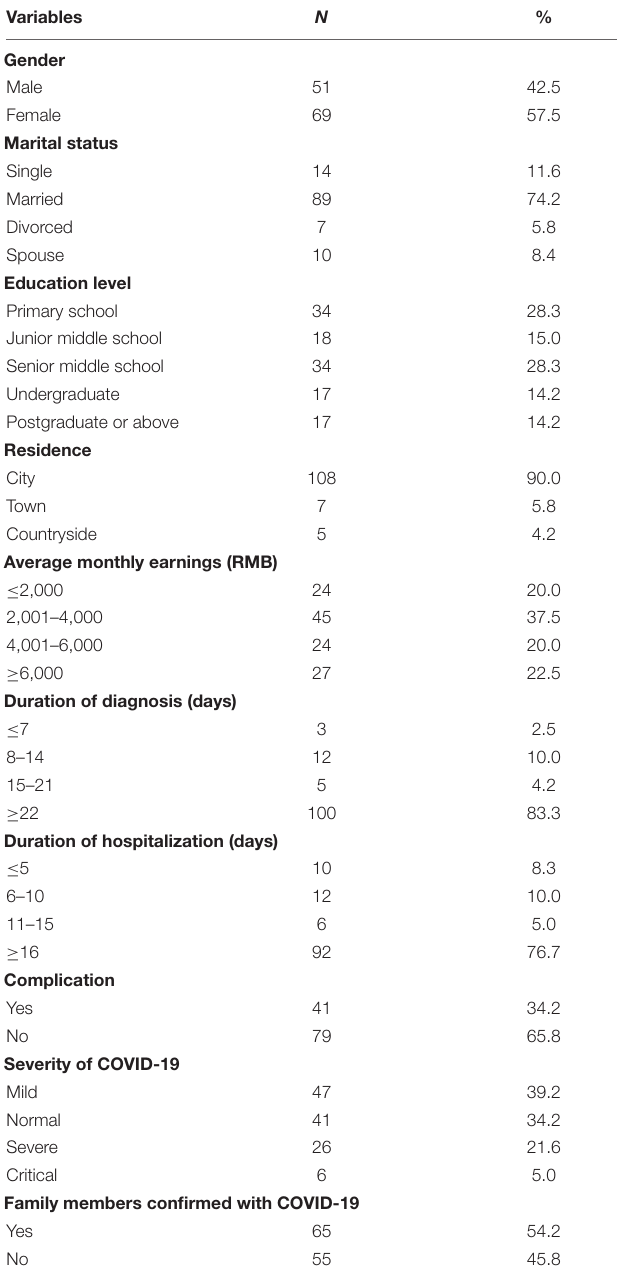
TABLE 2 | Sociodemographic and clinical characteristics of patients with mild symptoms of coronavirus disease 2019 ( N = 120).